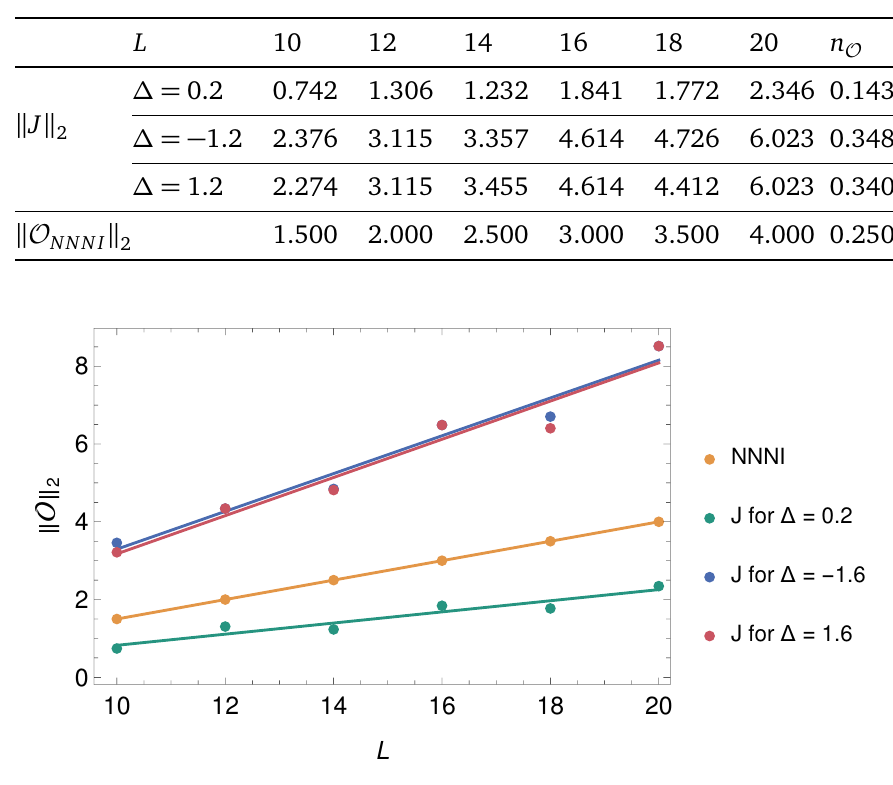
Figure 1: Norm of J and O as a function of the system size L in the three NNNI